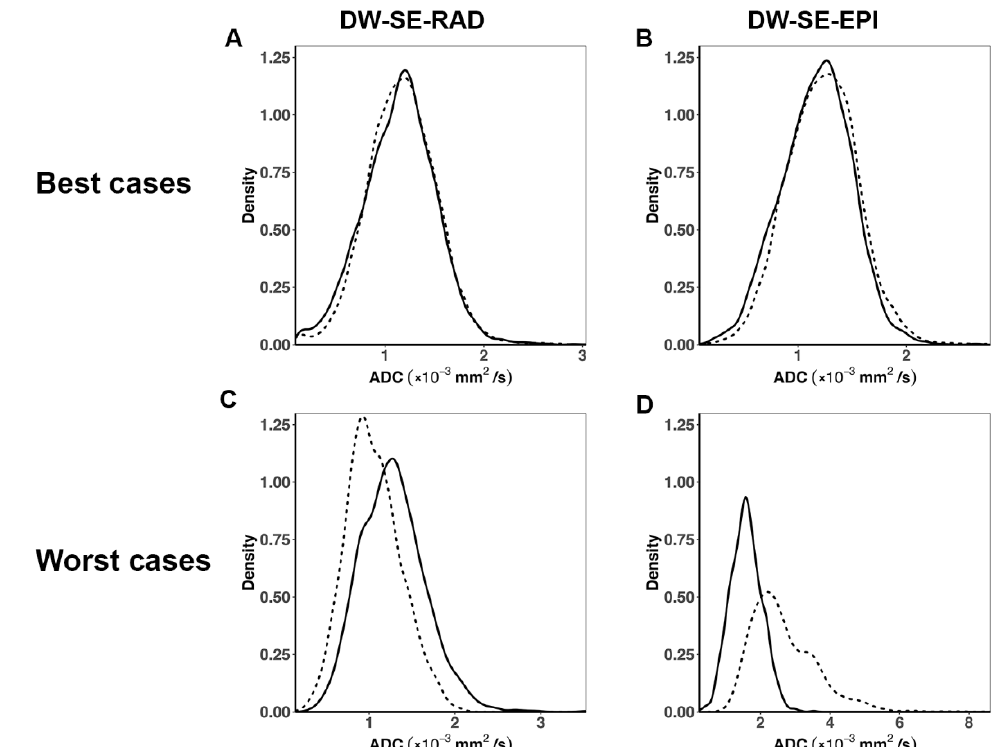
Figure 5. Probability density function (PDF) of the pixel-wise tumor ADC values from the best ( A , B ) and worst cases ( C , D ) in the test–retest study for the DW-SE-RAD and DW-SE-EPI protocols, respectively (solid line: test and dotted line: retest). The best and worst cases correspond to the smallest and largest ∆D values, respectively, from ten mice subjected to the test–retest study for each protocol.